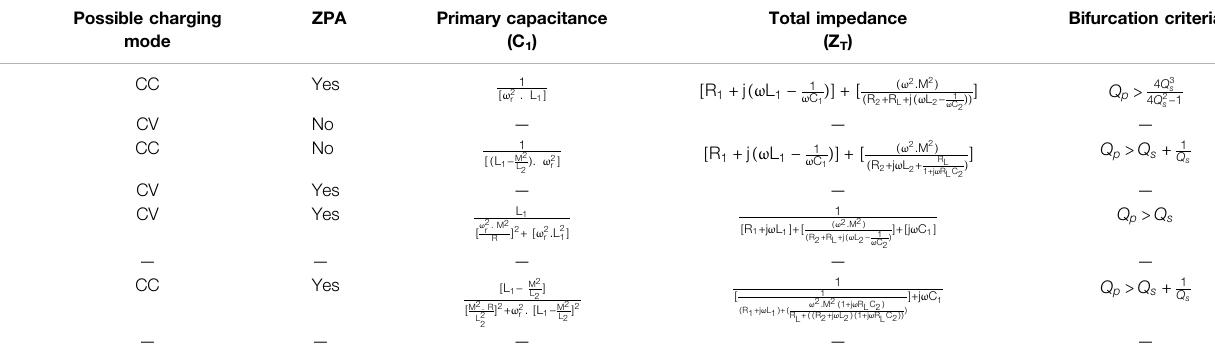
Table 2 . The shielding of the transmitter coil side is used to block